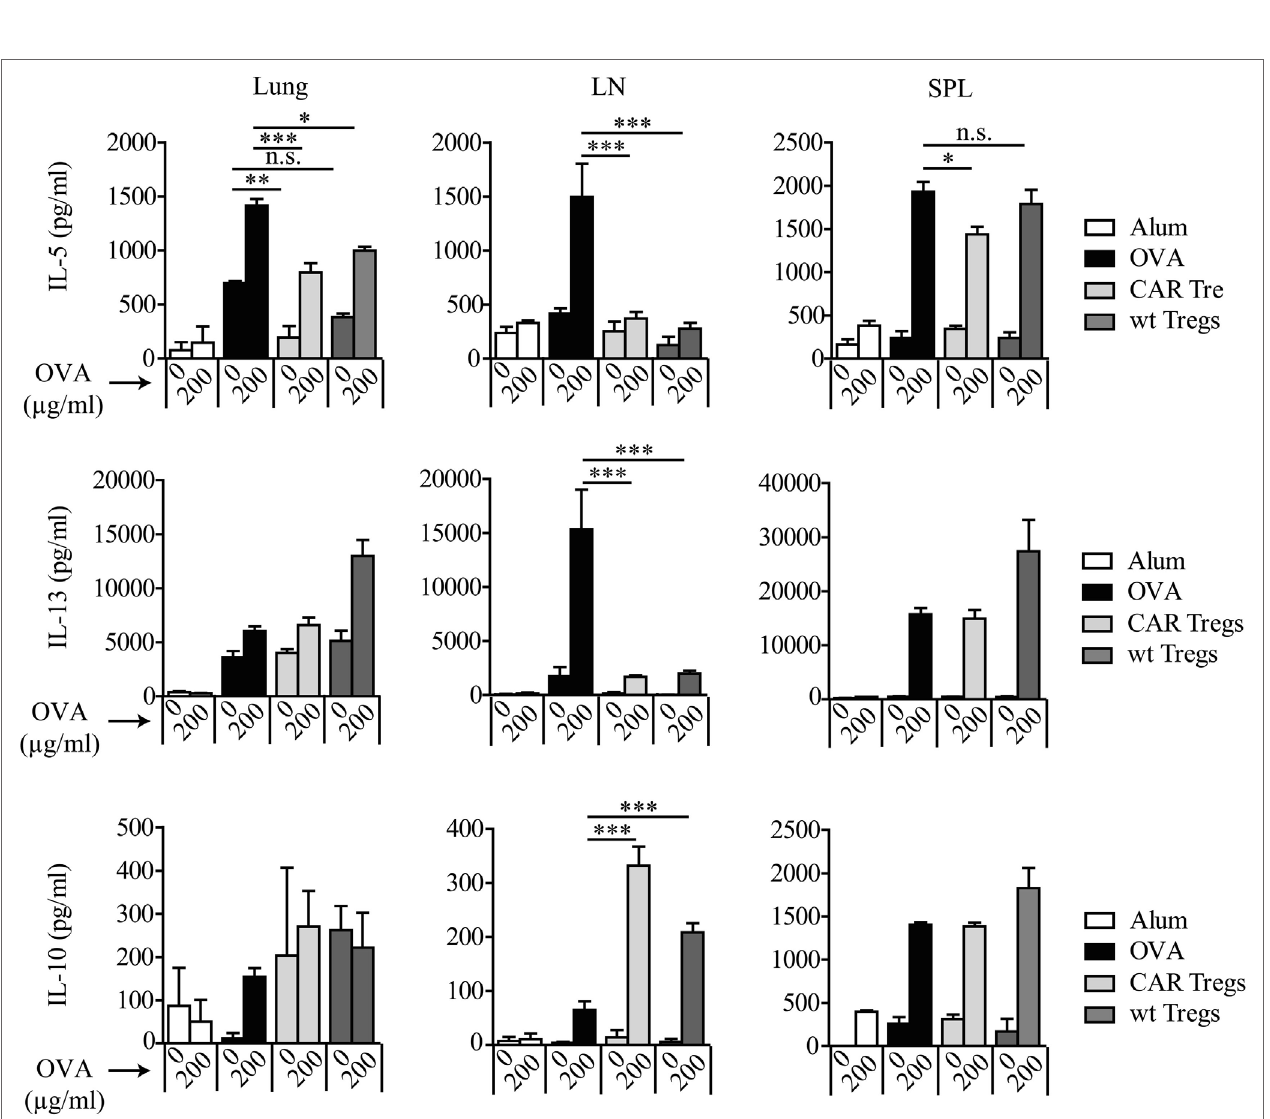
FigUre 4 | Chimeric antigen receptor (CAR) regulatory T cells (Tregs) reduce antigen-specific T helper-2 cytokine production by lung cells and splenocytes. IL-5, IL-13, and IL-10 levels were measured by bead-based assay in lung, spleen (SPL), and tracheobronchial lymph node (LN) cell culture supernatants after in vitro restimulation with 200 µg/ml ovalbumin (OVA). Data represent three independent experiments including pooled samples from more than 6 mice per group. Statistical analyses were performed by the one-way ANOVA test. * p < 0.05, ** p < 0.01, *** p < 0.001.